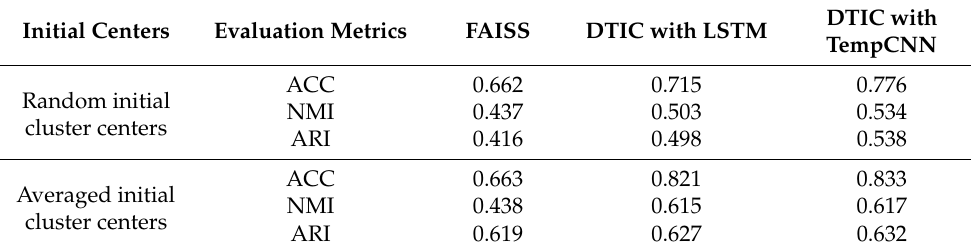
Table 7. A comparison of the optimal performance of various K-means clustering algorithms on the Reunion Island Dataset with random and averaged initial cluster centers.